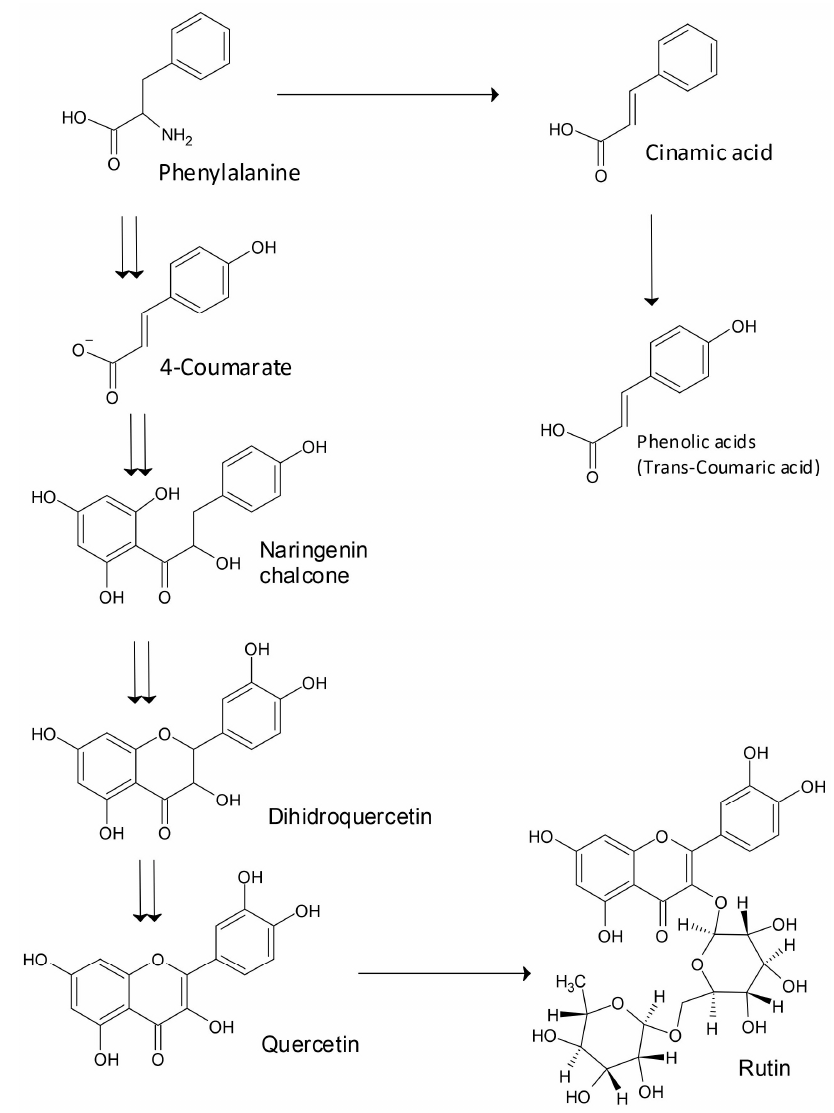
Figure 1. Basic biosynthesis pathway for the synthesis of flavonoids rutin and quercetin, and phenolic acids.